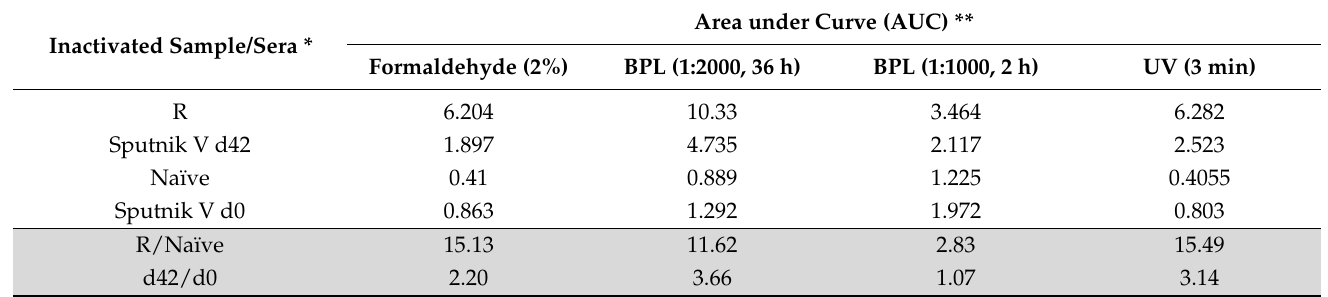
Table 3. Immunoreactivity of SARS-CoV-2 inactivated with different agents measured with ELISA.